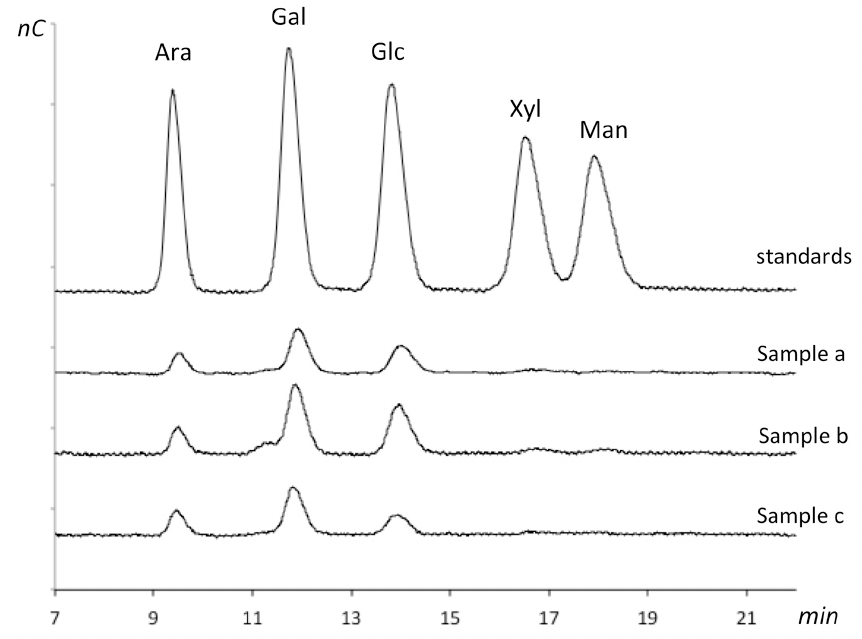
Figure 11. Monosaccharide composition of the hydrolyzed native carbohydrates determined by HPAEC-PAD. The chromatograms show presence of arabinose, galactose and glucose. The standards include arabinose (Ara), galactose (Gal), glucose (Glc), xylose (Xyl) and manose (Man). The samples were analyzed in triplicate (a, b, c).